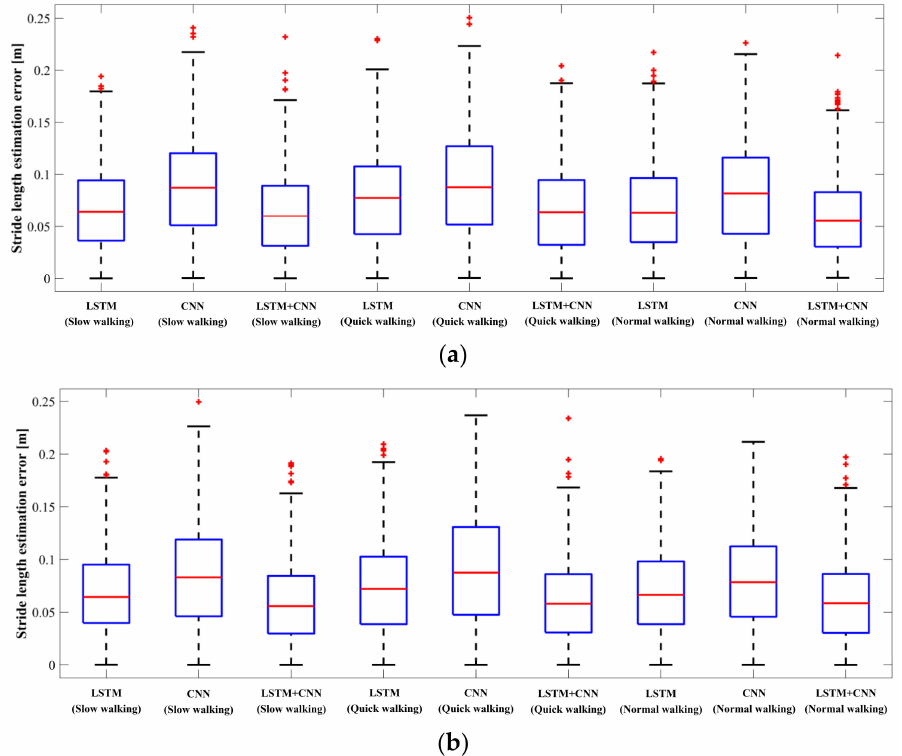
Figure 10. Box-plot of stride-length estimation error in three walking modes (slow walking, normal walking, and quick walking) with sequences #7 ( a ) and #11 ( b